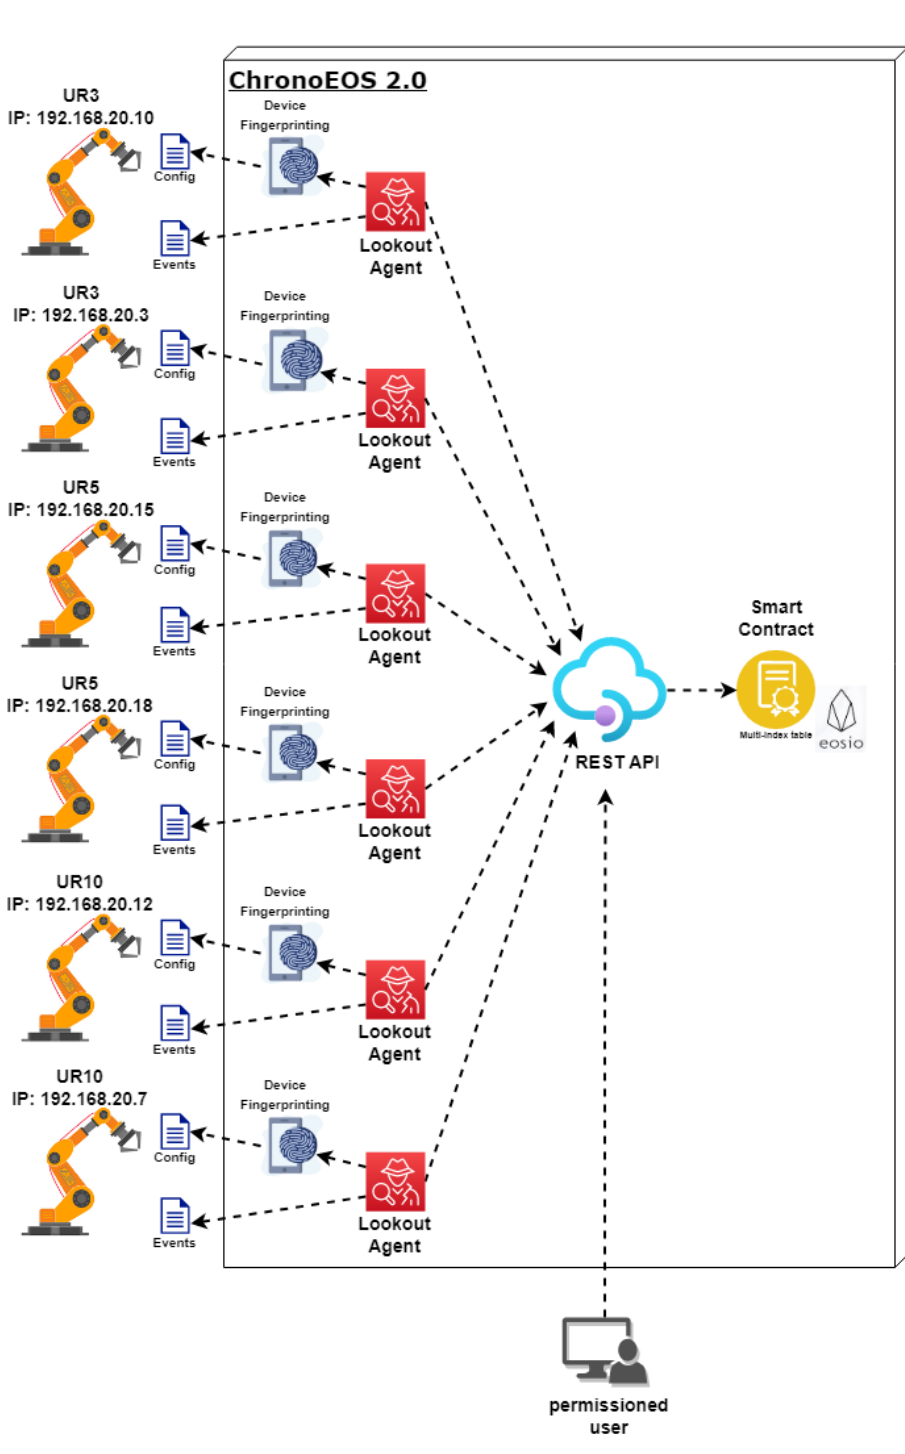
Figure 2. The diagram of the selected environment, where ChronoEOS 2.0 was deployed to be